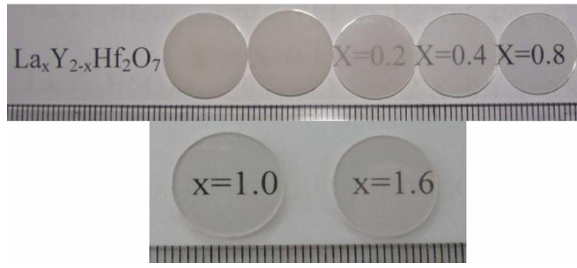
Fig. 9 Photograph of La 2– x Y x Hf 2 O 7 ceramics ( x = 0–1.6) (polished, 1 mm thick). Reproduced with permission from Ref. [90], © Chinese Academy of Sciences 2011.